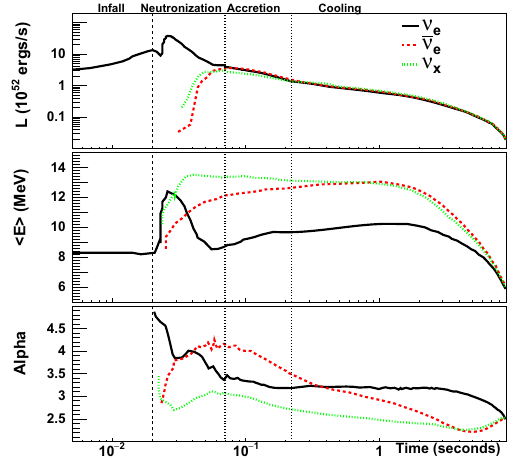
Fig. 1 Expected time-dependent flux parameters for a specific model foranelectron-capturesupernova[8].Noflavortransitionsareassumed. The top plot shows the luminosity as a function of time, the second plot showsaverageneutrinoenergy,andthethirdplotshowsthe α (pinching) parameter. The vertical dashed line at 0.02 s indicates the time of core bounce, and the vertical lines indicate different eras in the supernova evolution. The leftmost time interval indicates the infall period. The next interval, from core bounce to 50 ms, is the neutronization burst era, in which the flux is composed primarily of ν e . The next period, from 50 to 200 ms, is the accretion period. The final era, from 0.2 to 9 s, is the proto-neutron-star cooling period. The general features are qualitatively similar for most core-collapse supernova